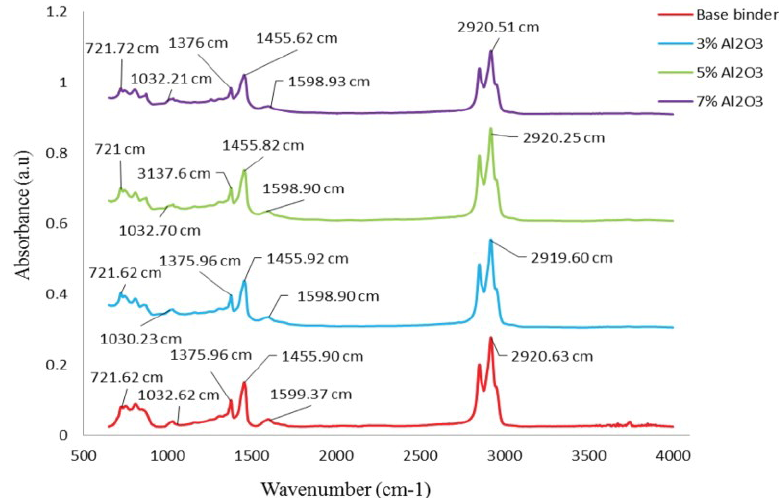
Figure 5. Spectra of the neat and Al 2 O 3 -modified bitumens studied by Ali et al.